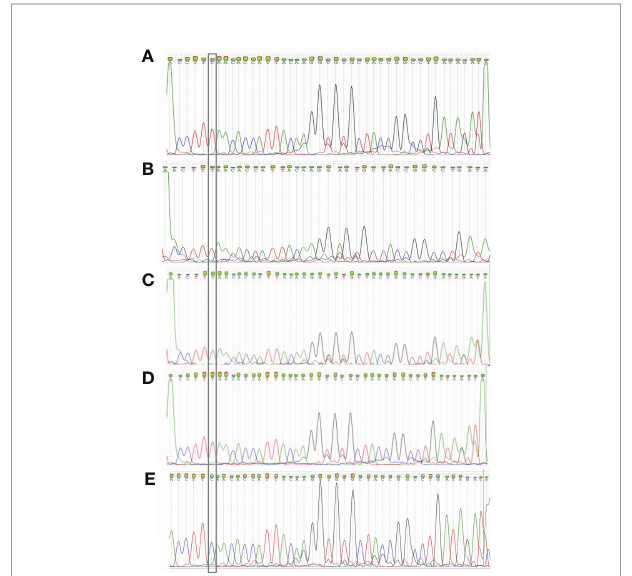
FIGURE 6 | Electropherograms obtained from the Sanger sequencing of four samples. (A) 150441 patient; (B) 150 450 patient; (C) 138227 patient; (D) 139093 patient; (E) L782 patient. The fi rst 4 samples show the E484K mutation, and the fi fth is a wild-type sample. The inset highlights the position of the mutation, which shows that the original base “ C ” changed to a “ T ”